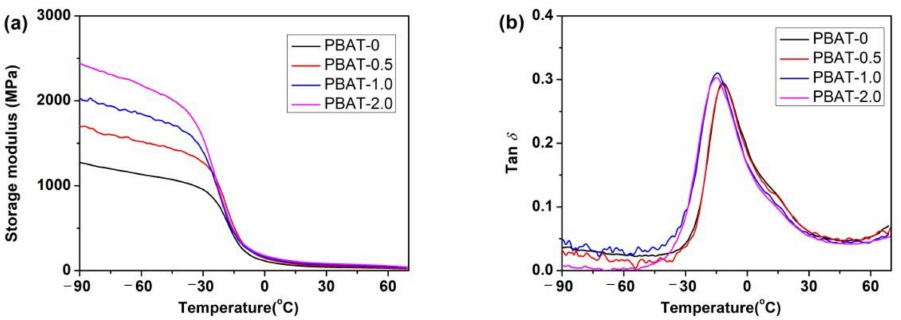
Figure 5. ( a ) Storage modulus and ( b ) loss factor of PBAT/Ti 3 C 2 T X nanocomposite casting